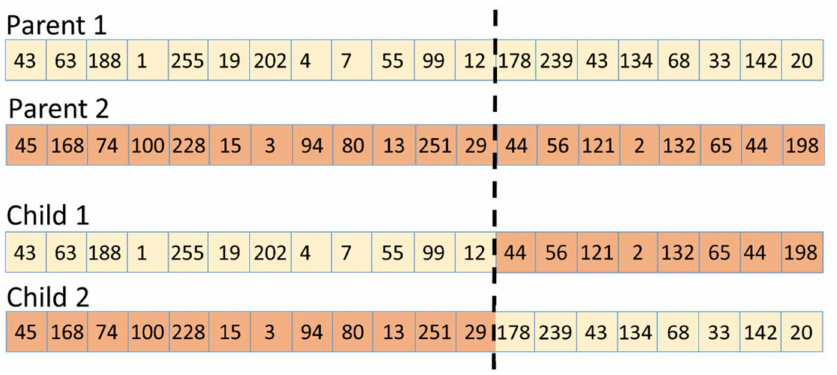
Figure 4. The representation of an individual containing 20 values of data items, each 8 bits wide.